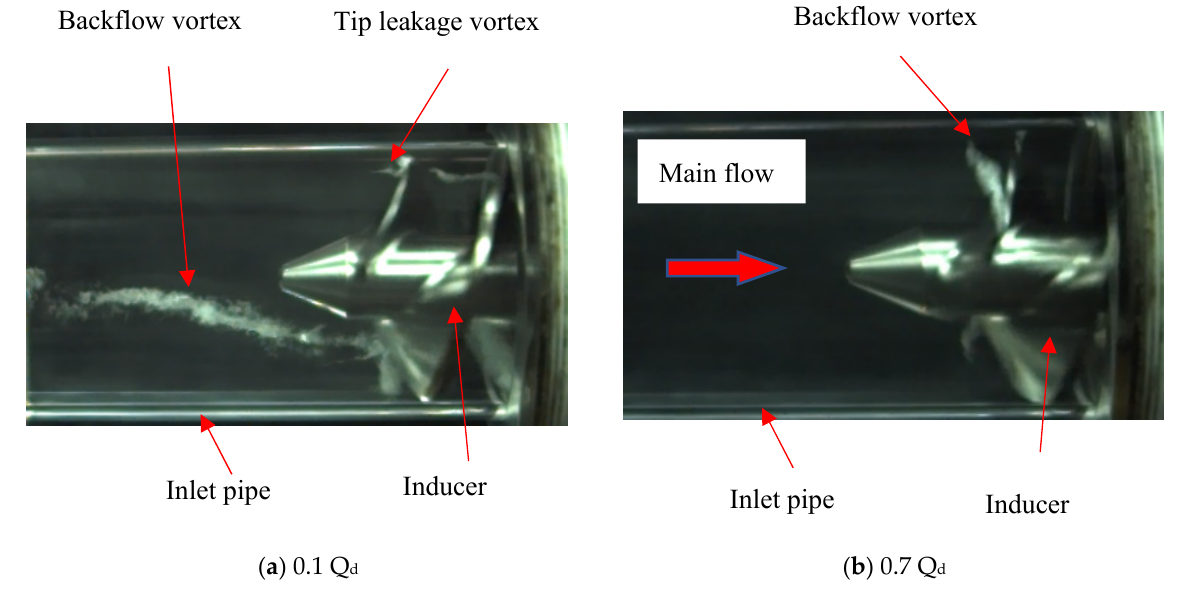
Figure 7. Visual image of the inducer under NPSH = 10 m.